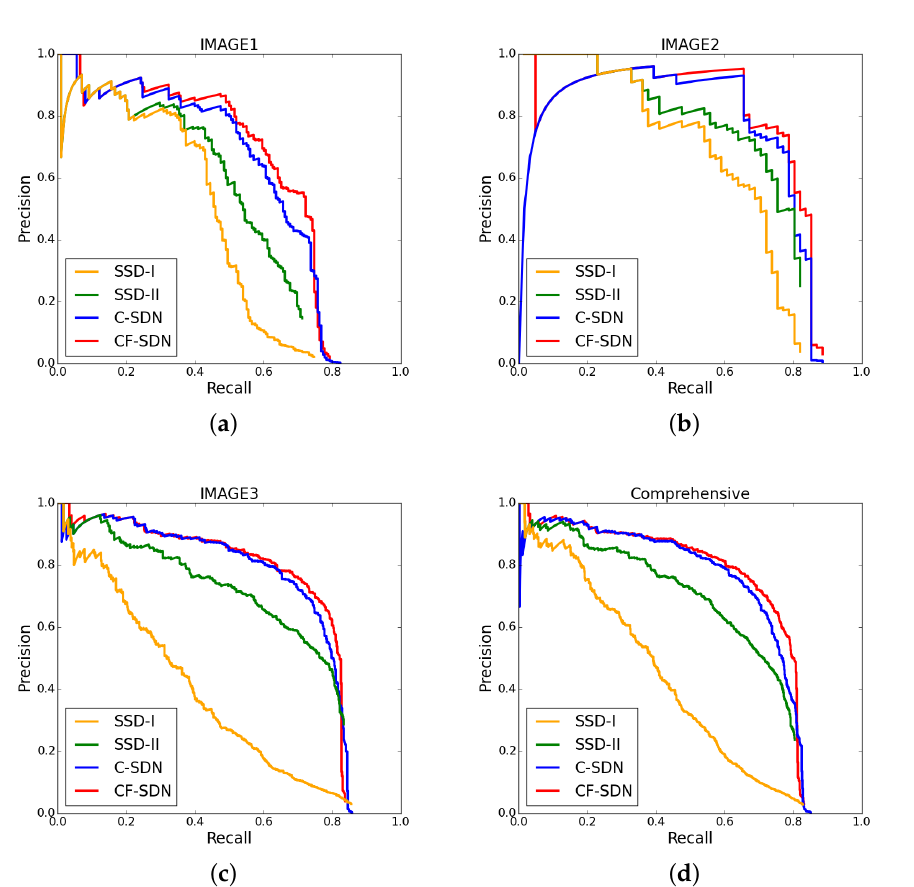
Figure 16. Performance comparison of with and without sea-land separation on the testing set in terms of the P-R Curves. ( a ) Comparison of detection performance on IMAGE1. ( b ) Comparison of detection performance on IMAGE2. ( c ) Comparison of detection performance on IMAGE3. ( d ) Comparison of detection performance on the whole testing data